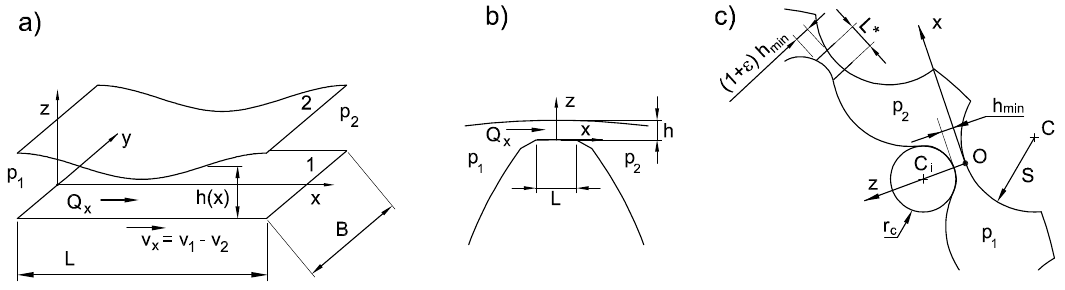
Figure 9. ( a ) Generic gap with variable height; ( b ) gap on the tooth tip for external gear and crescent pumps; ( c ) variable height gap in gerotor pumps.